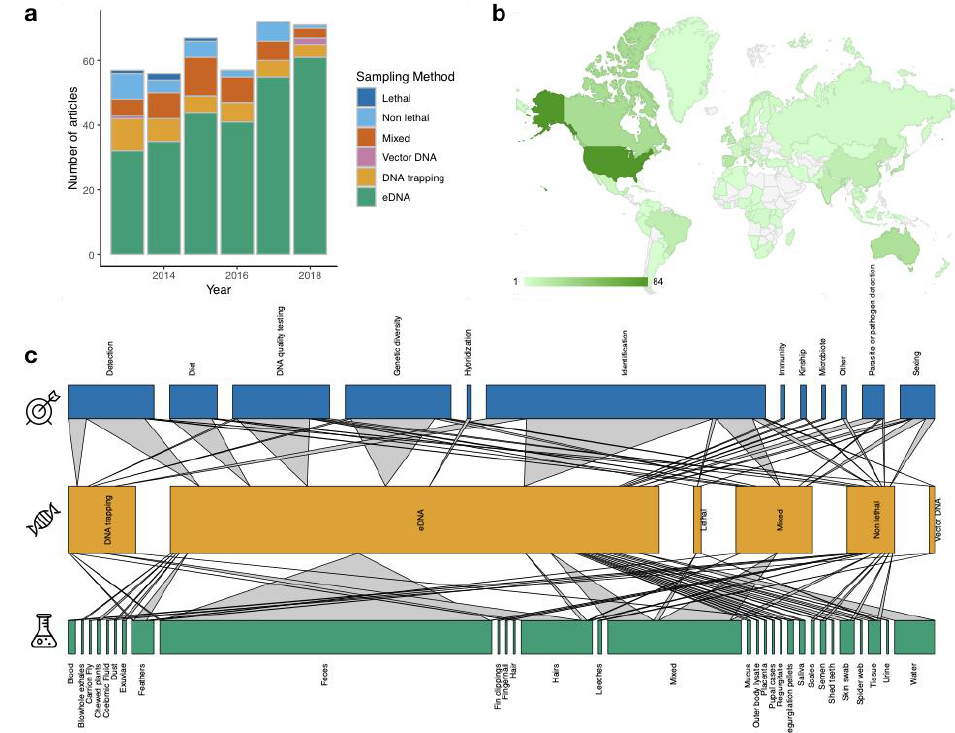
Figure 1 . Summary statistics of the literature review on the use of “non - invasive DNA sampling” between January 2013 and December 2018 (n=380). a: Number of articles in relation to the sampling method used between 2013 and 2018. b : Countries of origin of the samples analysed in the reviewed papers. Countries in grey were not represented in our review, countries coloured in various shades of green provided samples for 1 to 84 of the reviewed papers (see in-graph legend for colour scale). c : Table 1 for definitions) and the nature of the samples collected in green. The horizontal width of the rectangles is proportional to the number of articles in each